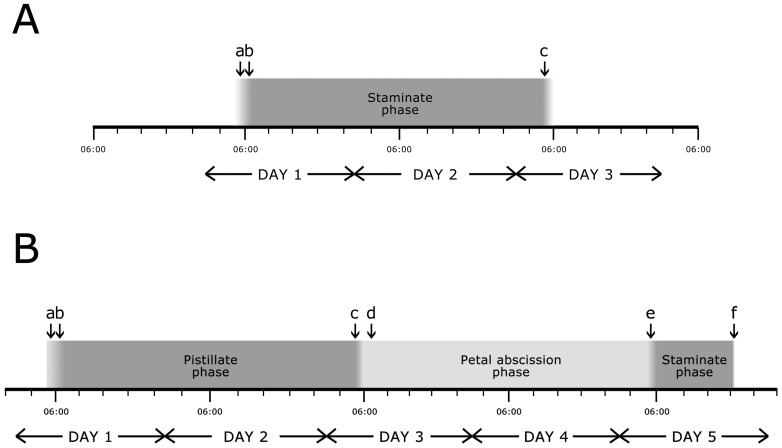
Timing of phenological events in flowers of Pseuduvaria mulgraveana during sexually functional phases.(A) Staminate flowers: a  =  initiation of anther dehiscence and nectar secretion; b  =  arrival of pollinators; c  =  petal abscission and departure of pollinators. (B) Structurally hermaphroditic flowers: a  =  start of stigma exudation and nectar secretion; b  =  arrival of pollinators; c  =  petal abscission and departure of pollinators; d  =  cessation of stigmatic receptivity; e  =  initiation of anther dehiscence of the staminodes; f  =  abscission of staminodes. Numbering of days in (A) and (B) is not correlated.